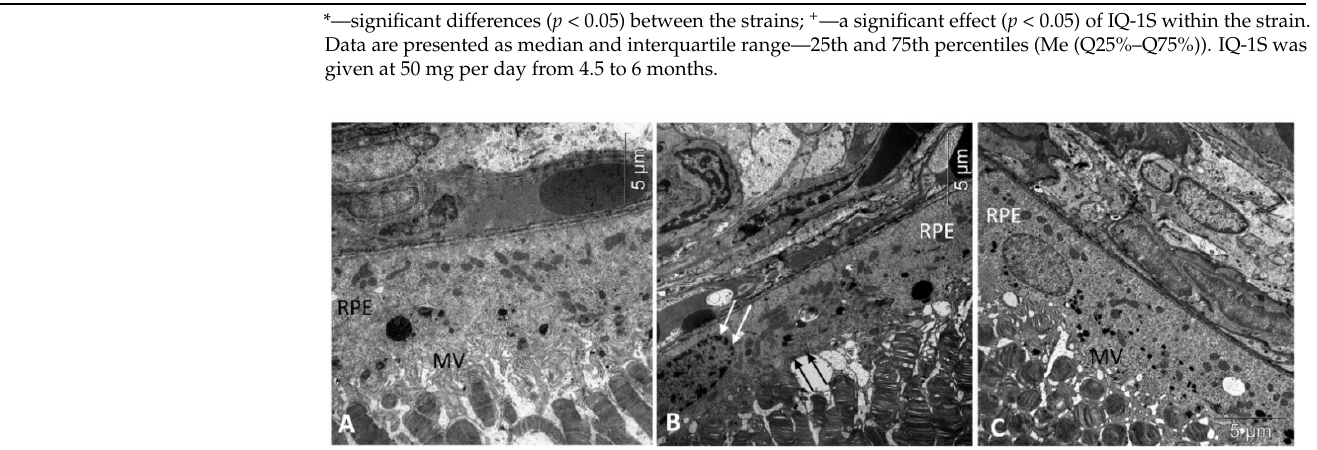
Figure 1. Treatment with IQ-1S improved the structural and functional parameters of RPE in 6-month-old OXYS rats. Electron micrographs show examples of normal ultrastructural signs of RPE in Wistar rats ( A ), untreated ( B ), and IQ-1S treated ( C ) OXYS rats. RPE images from untreated OXYS rats ( B ) show evidence of RPE cell disorganization-nuclear chromatin condensation (arrow) and microvilli destruction (black arrows) in OXYS rats. RPE cells from OXYS rats treated with IQ-1S ( C ) have normal nuclear and cytoplasmic ultrastructure. The presence of microvilli (MV) on their surface indicates that the cells are functionally active. Table 1. Effects of IQ ‐ 1S on the morphometric parameters of the Retina of OXYS Rats.